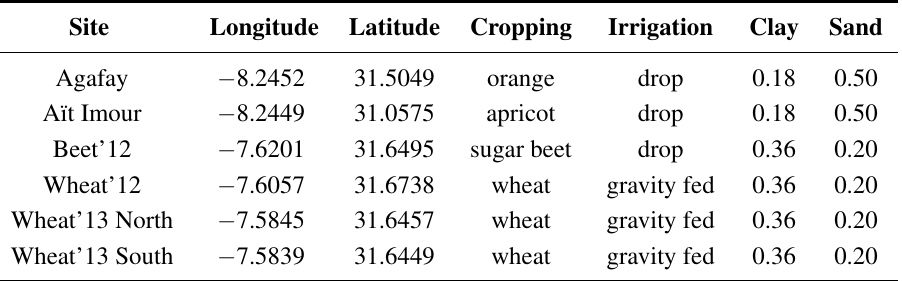
Table 2. Soil moisture monitoring